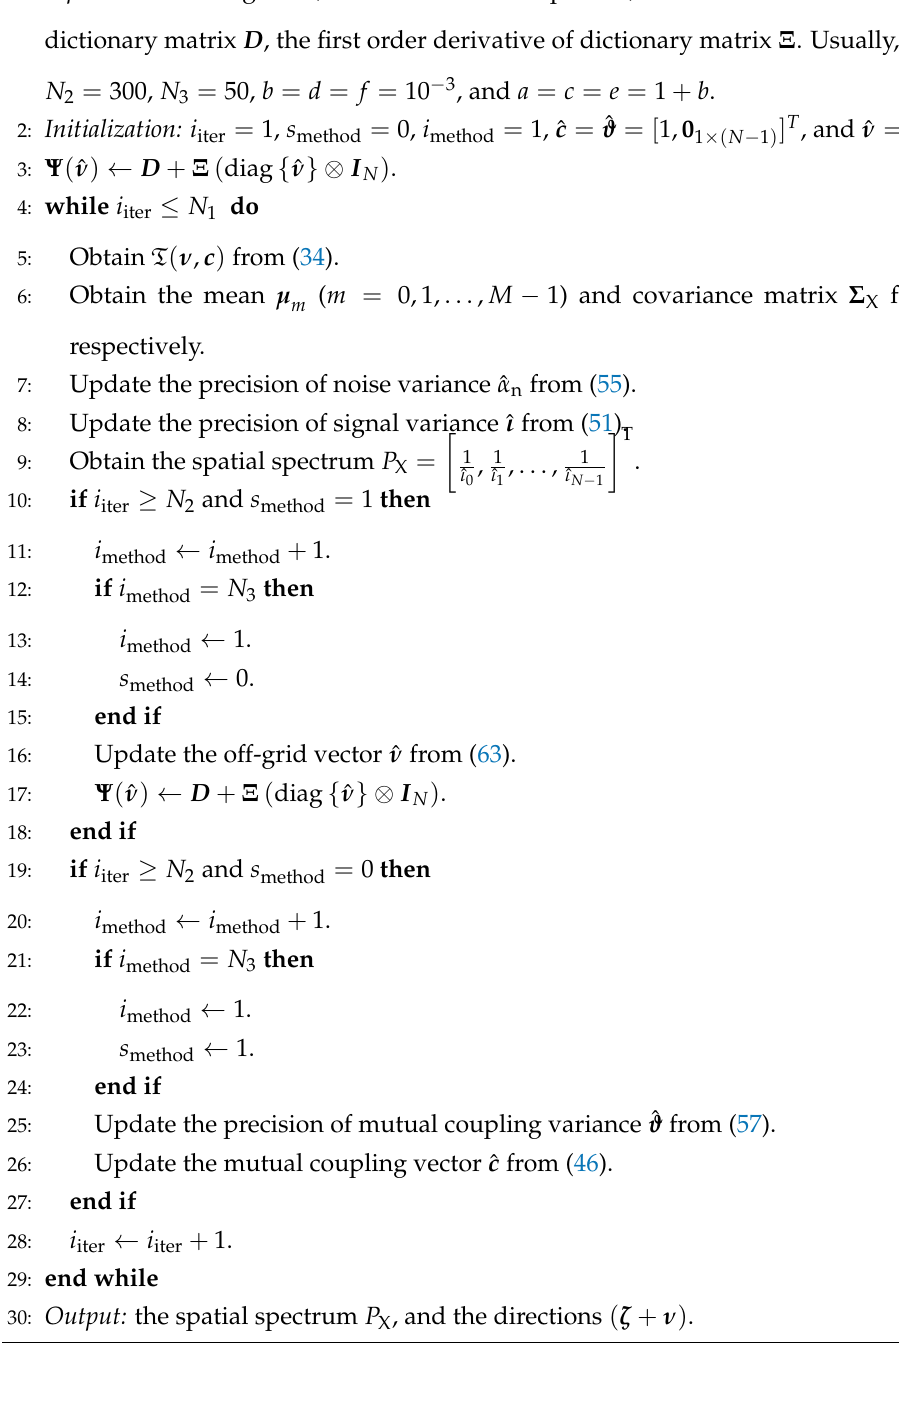
Algorithm 1 DFSMC algorithm for direction finding with the unknown mutual coupling